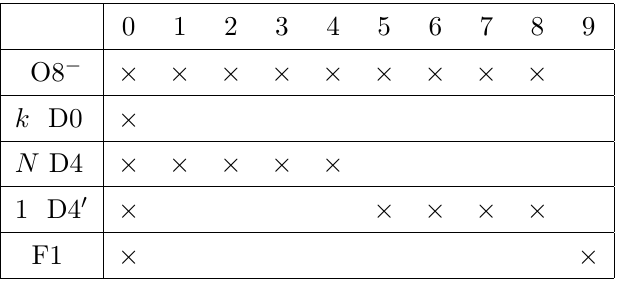
Table 5 . The directions of the various branes.